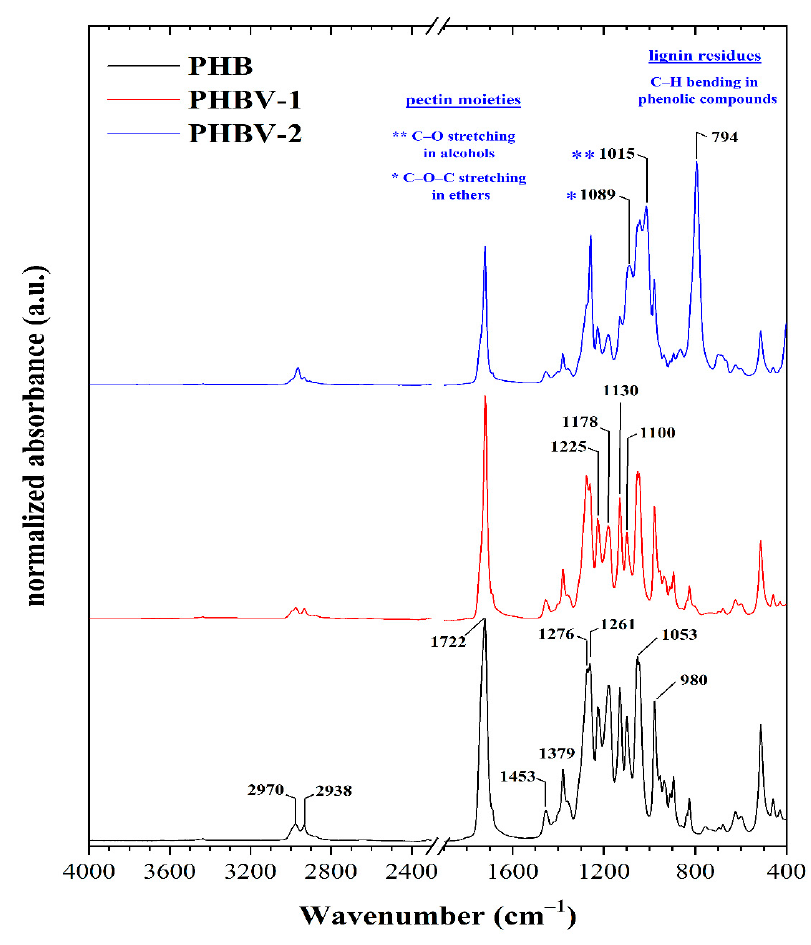
Figure 2. Attenuated total reflectance (ATR)-FTIR spectra of PHB, PHB-1, and PHB-2.